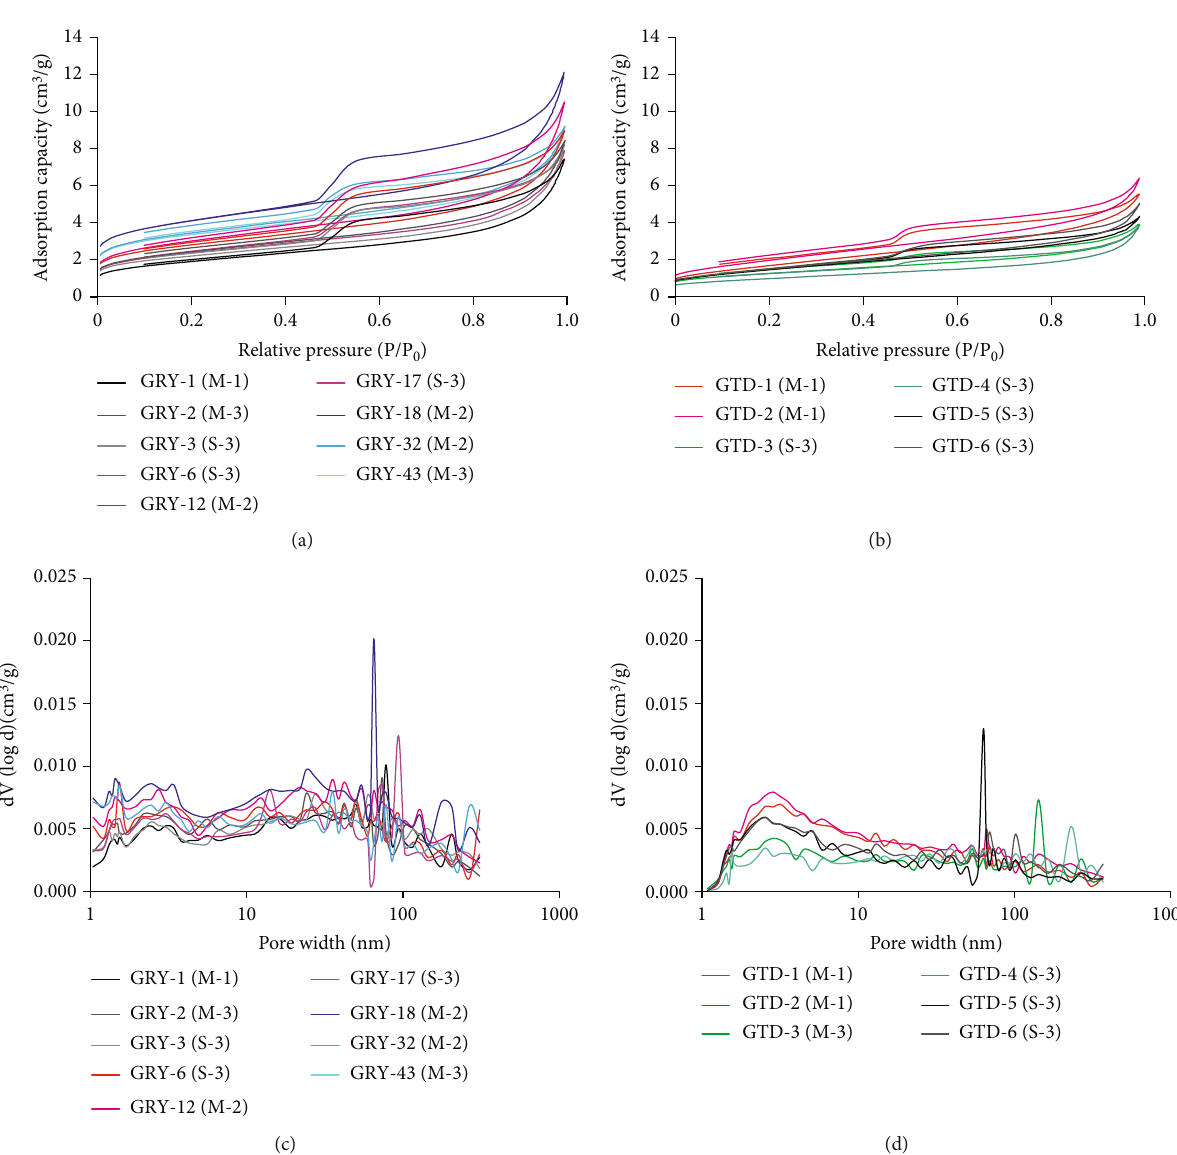
adsorption curve of Devonian shale samples in well 2 pore diameter distribution curve of 2